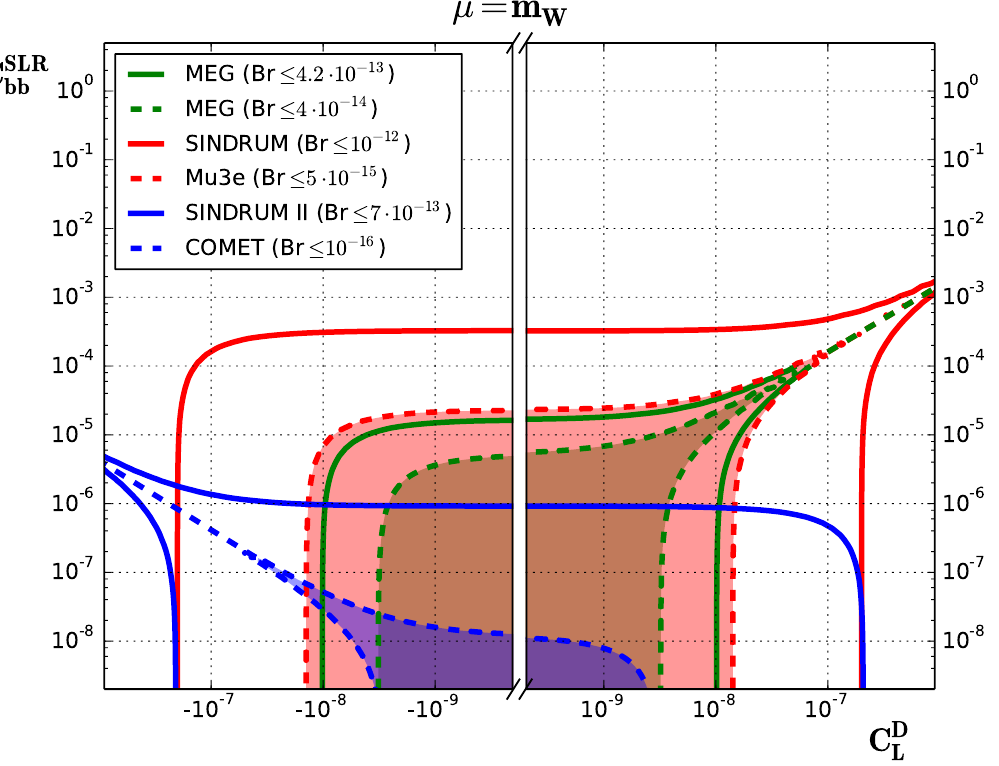
Figure 6. Allowed regions in the C D conversion (blue) for current (straight) and future (dashed) experimental